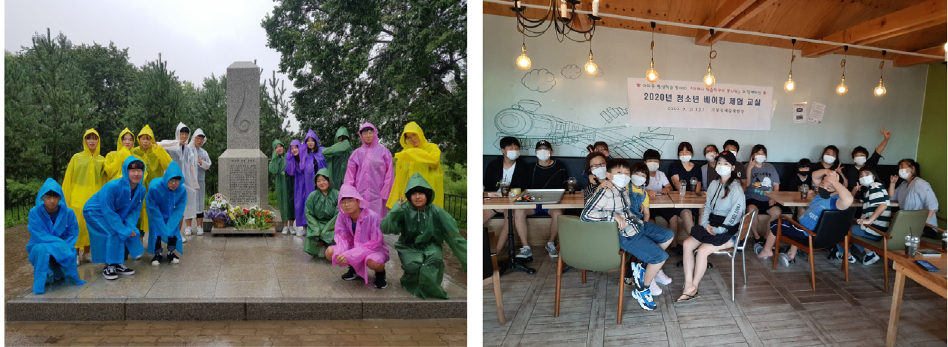
Figure 13. Children participating in a travel group program and other events.